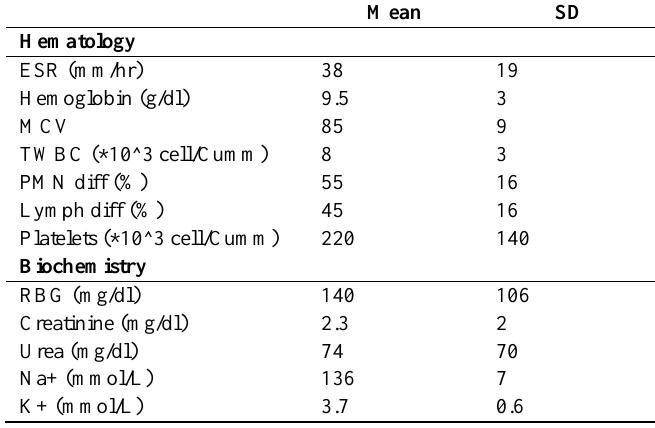
Table 3: The laboratory investigations of severe malaria patients